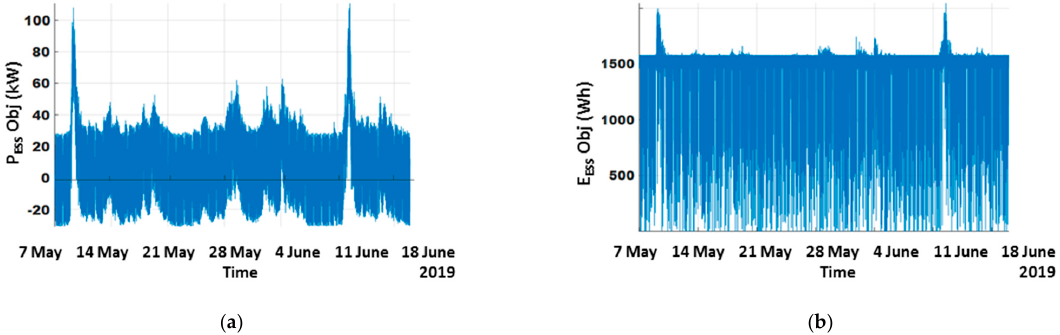
Figure 13. ( a ) Power profile that the ESS has to supply to meet the active power ramp-rate limit requirement and ( b ) ESS energy calculated in 15 min periods from required power.